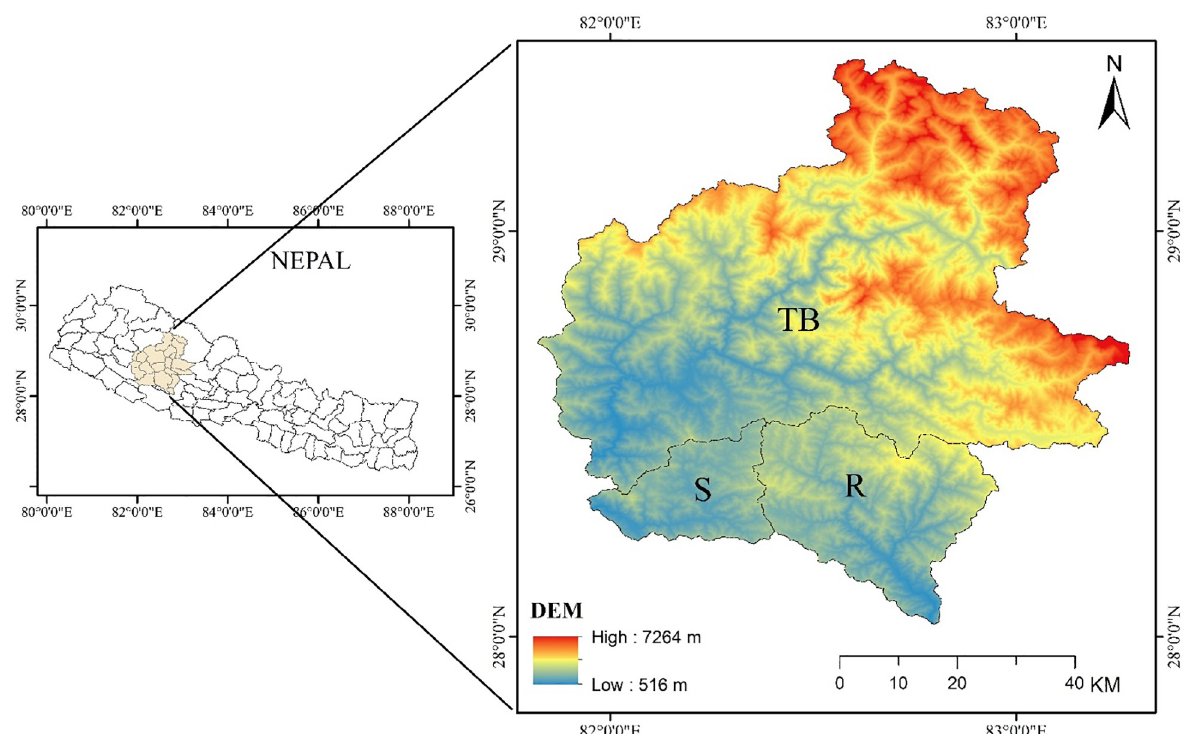
Fig 1. Study area covering the three river basins with the DEM (TB = Thuli Bheri, S = Sarada, R = Rapti).